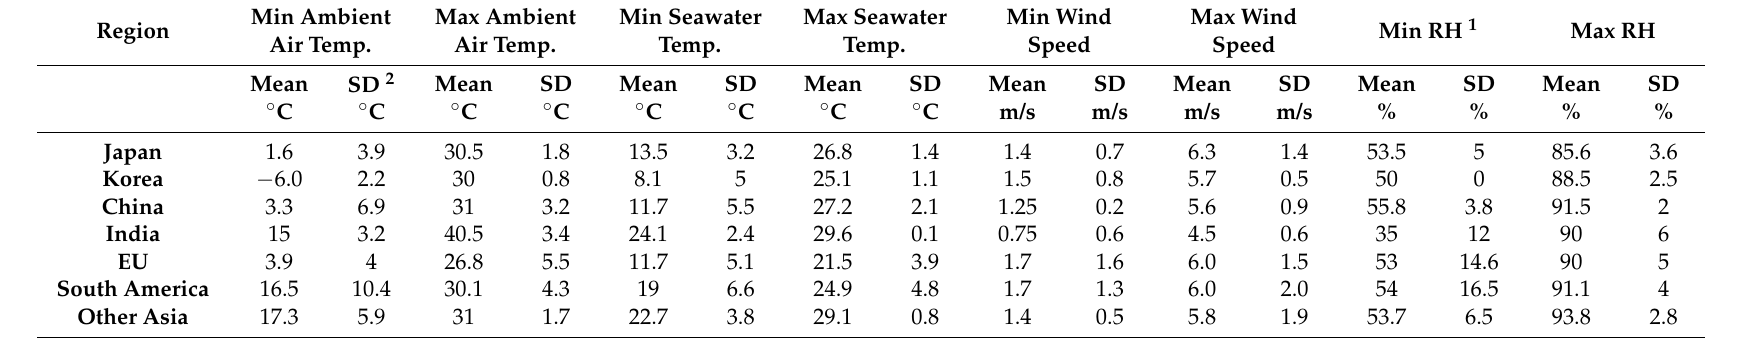
Table 2. Overview of location